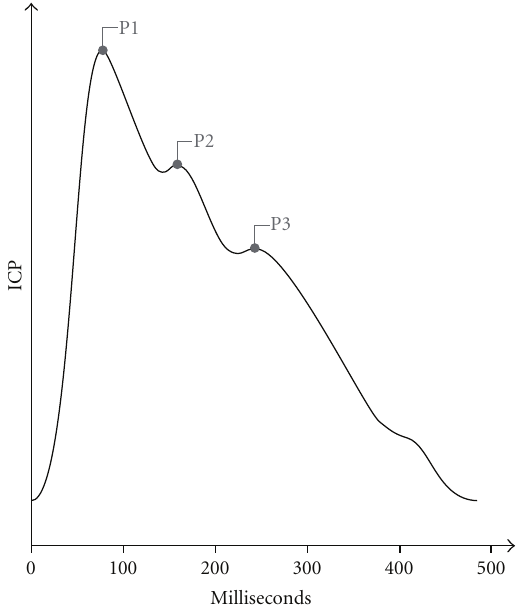
Figure 2: Propagation of the cardiac pulse pressure